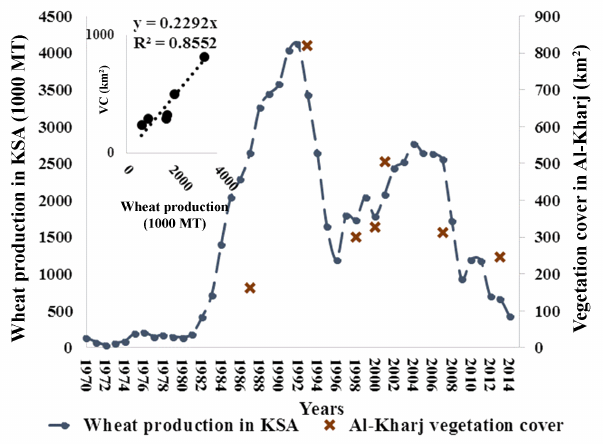
Figure 7. The changes of total vegetation cover (VC) (km 2 ) and wheat production (1000MT) of the Al-Kharj. The three RS dates, 1993, 1998, and 2001, were for Landsat-5 from Modaihsh et al. (2015). The 2007 image was from the Landsat Thematic Mapper from Algahtani et al. (2015).